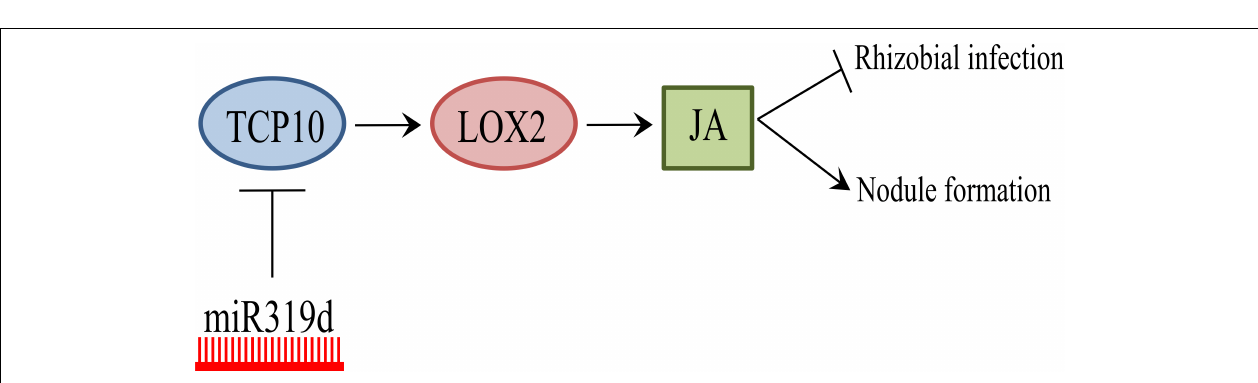
FIGURE 7 | Model of miR319d/TCP10 regulation in the common bean-rhizobia symbiosis. Positive regulation is represented with arrows and negative regulation with lines. A high level of miR319d induces TCP10 degradation (blue circle) that positively regulates the promoter activity of LOX2 gene (red circle) from the JA biosynthetic pathway. JA (green square) has a negative effect in rhizobial infection but a positive effect of nodule development in common